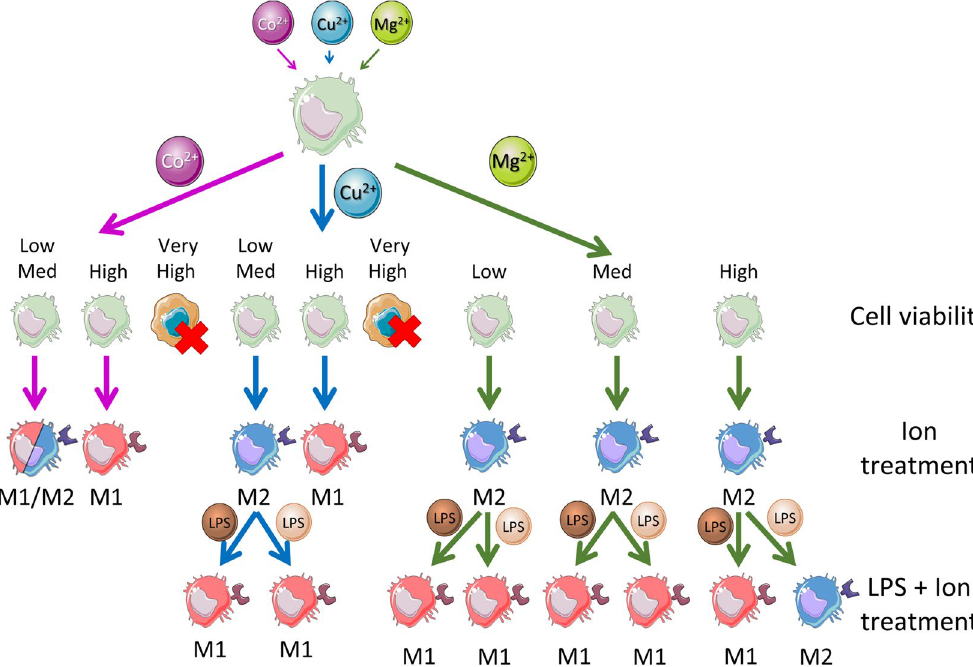
Figure 7. Schematic illustration of the macrophage phenotype promoted by Co 2+ , Cu 2+ and Mg 2+ bioactive ions, alone or in presence of a pro-inflammatory molecule such as LPS. Darker color of LPS represents a strong aggression, while a lighter color represents a mild aggression. This figure was produced using Servier Medical Art (http:// smart. servi er.